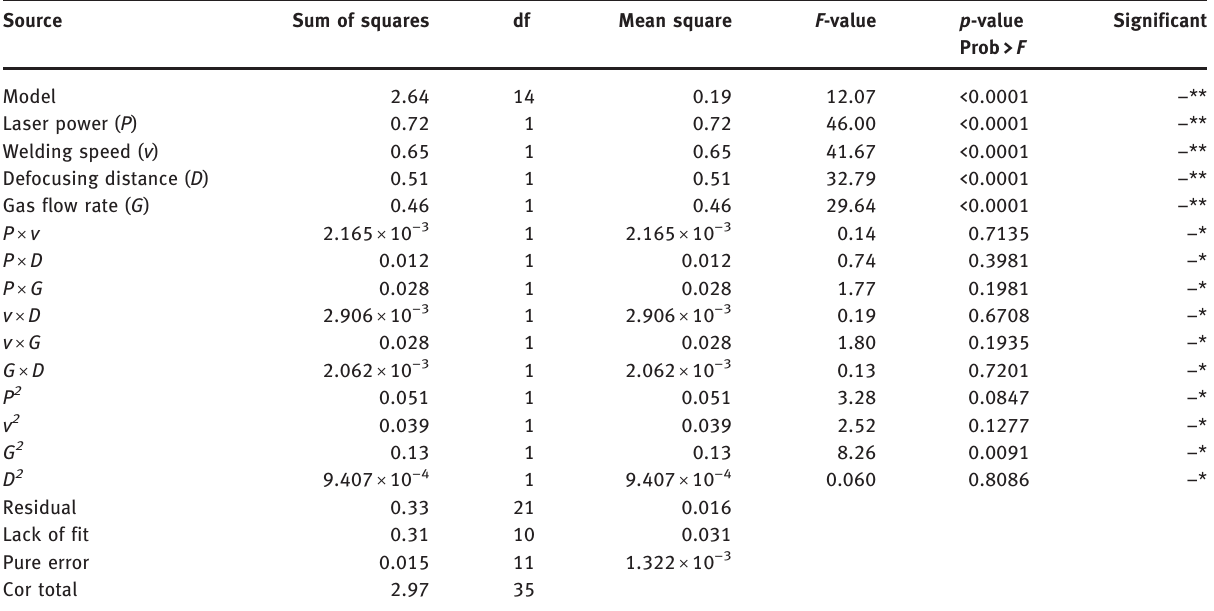
Table 8: Variance analysis of the quadratic